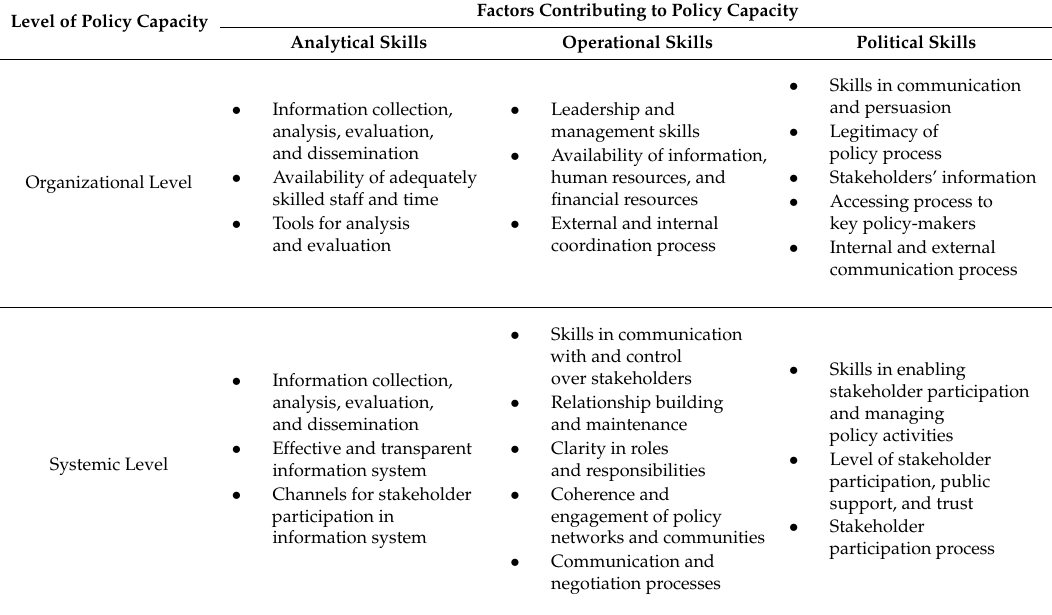
Table 4. Categorized factors contributing to policy capacity, following the analytical framework developed by Wu et al.